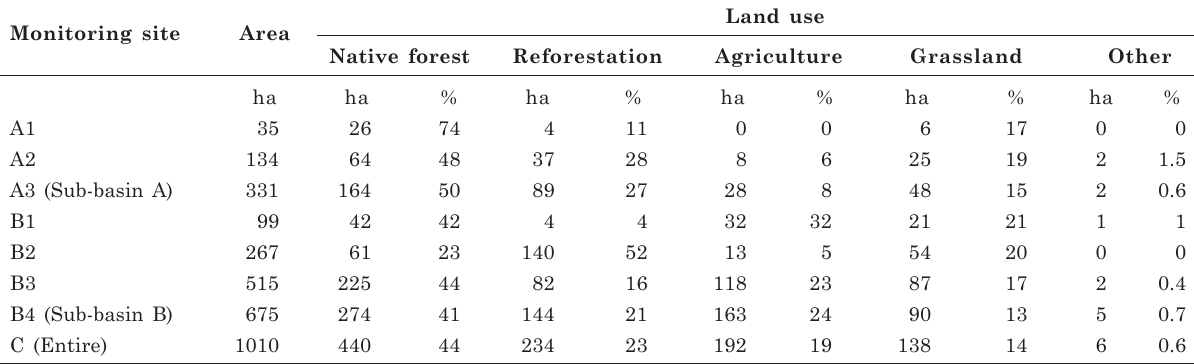
Table 2. Land use in the Campestre catchment